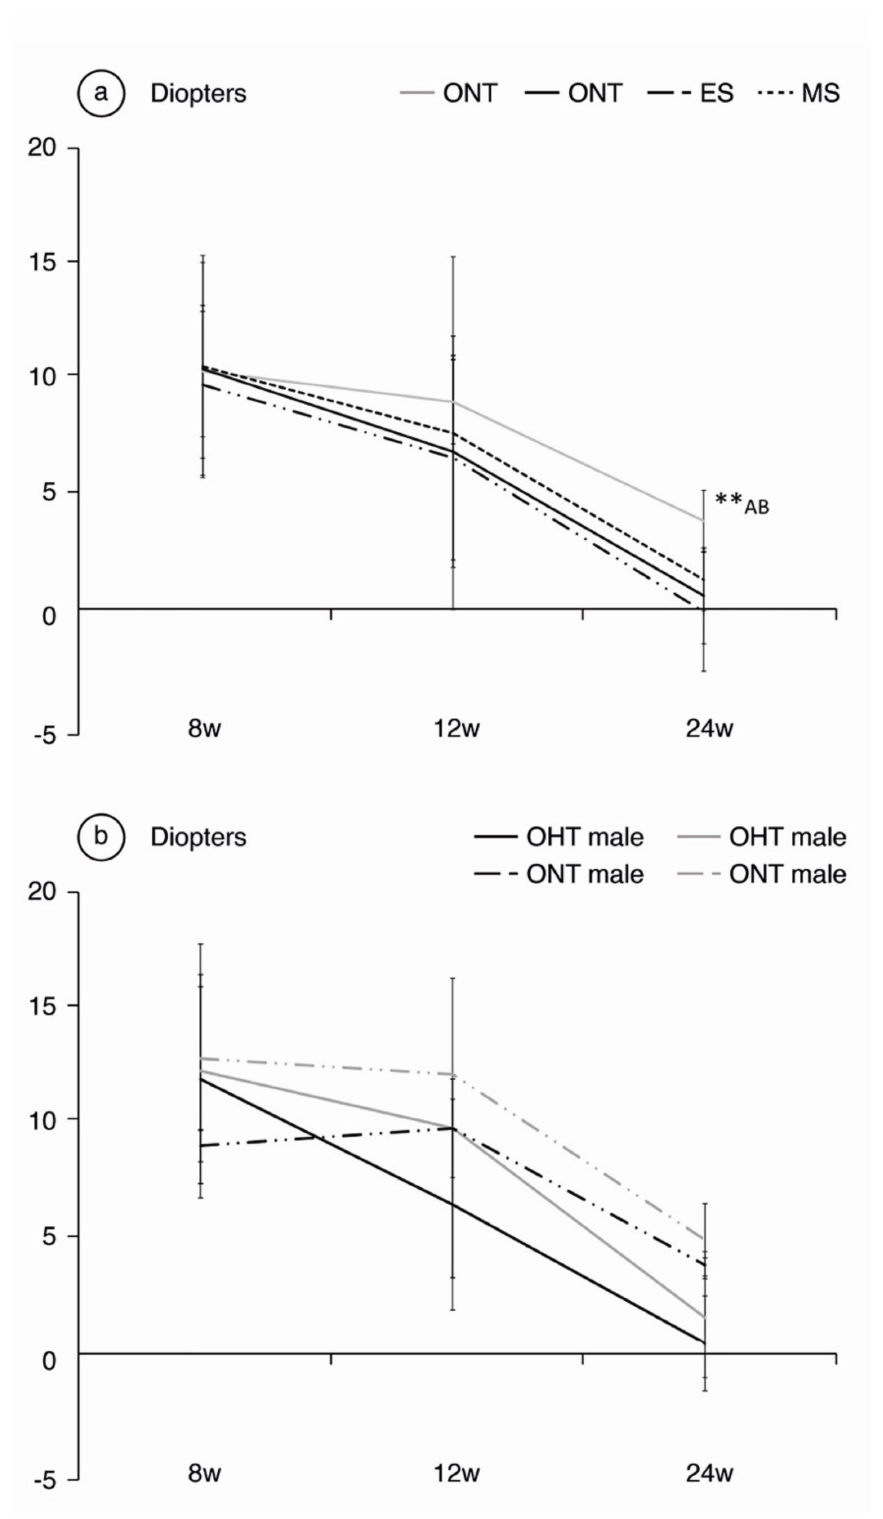
Figure 2. Analysis of refractive power in diopters over the 24-week follow-up, comparing the ocular normotension (ONT) and ocular hypertension (OHT) cohorts ( a ) and comparing both sexes ( b ). Abbreviations: w: week; ES: episcleral sclerosis group; MS: microspheres group; **: statistical differences between groups (ONT vs.ES vs. MS) (Kruskal Wallis); A: statistical differences between ONT and ES; B: statistical differences between ONT and